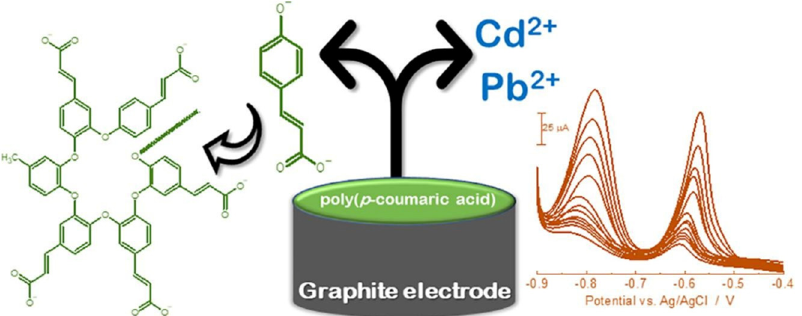
Figure 7. Poly (p -coumaric acid)-based sensor and its response towards the mixture of cadmium and lead in square-wave anodic stripping mode. Reprinted from [37] with permission from Elsevier.